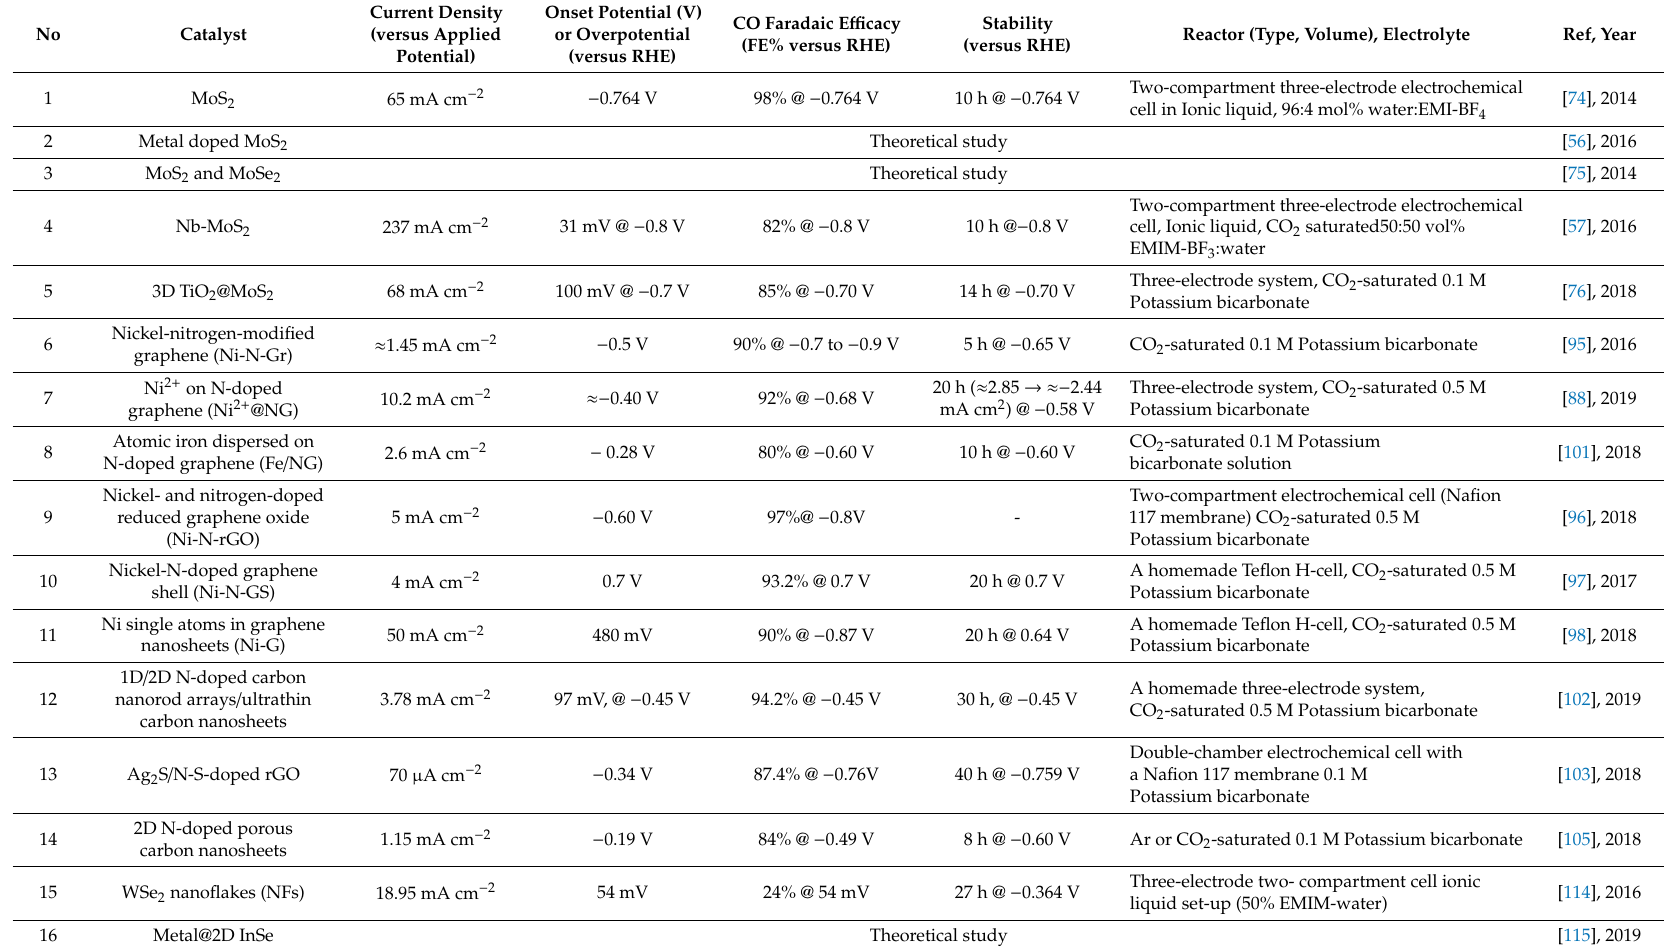
Table 2. The summary of various 2D nanomaterials for electrochemical CO 2 reduction. Details included reactor type, example of catalysts, current density, onset potential, over potential, and the main product of CO 2 reduction with faradaic e ffi ciency and